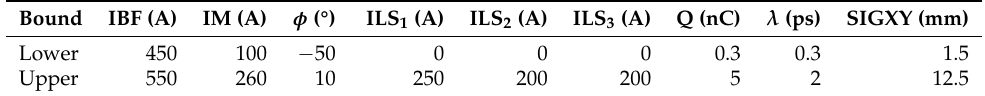
Table A3. The design variables and their ranges for the AWA models.